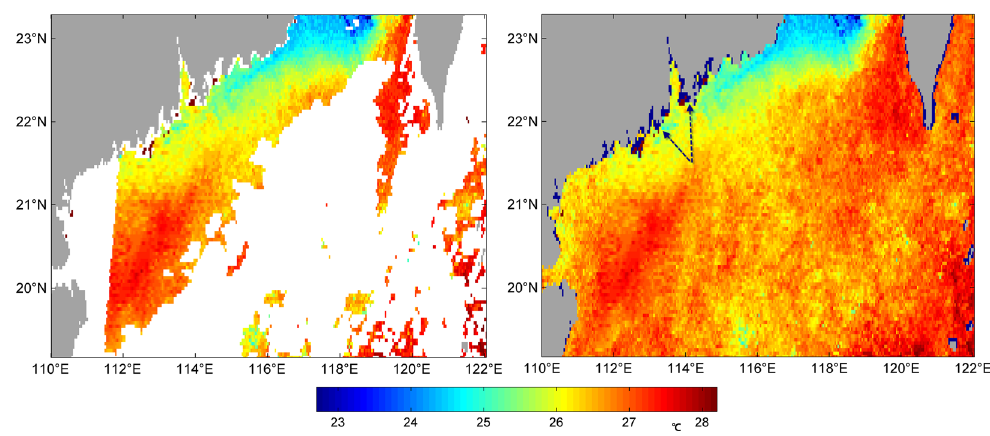
Fig 3. Left panel: original gappy image for 25 th October, 2011; right panel: its reconstruction image. The dark blue points shown by arrows represent the points with less than 5% good data in the temporal